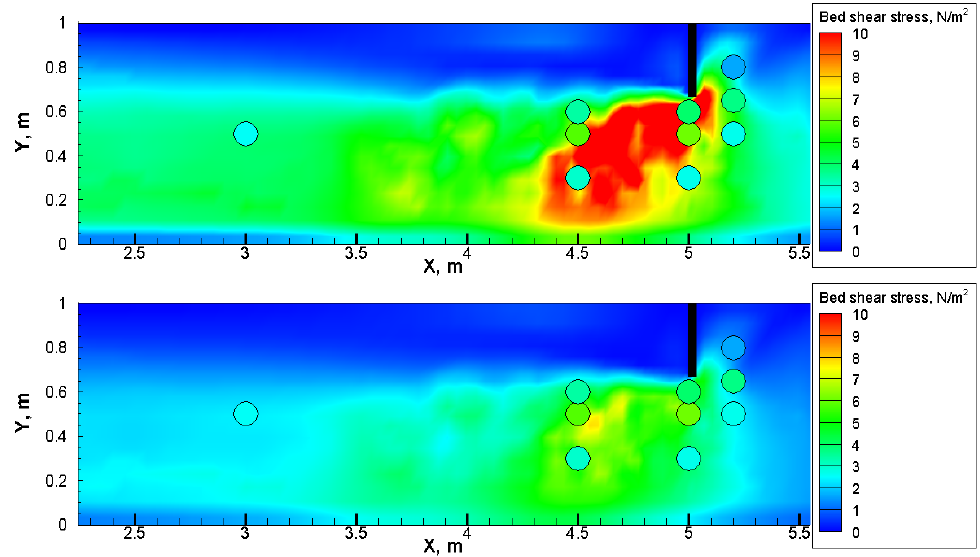
Figure 6. Calculated bed shear stress distribution by the numerical 3D model. Above: k s = 3.0 d 90 ; below: k s = 0.84 d 90 . Circles refer to the estimated shear values from the ADV (Acoustic Doppler Velocimeter) measurements.